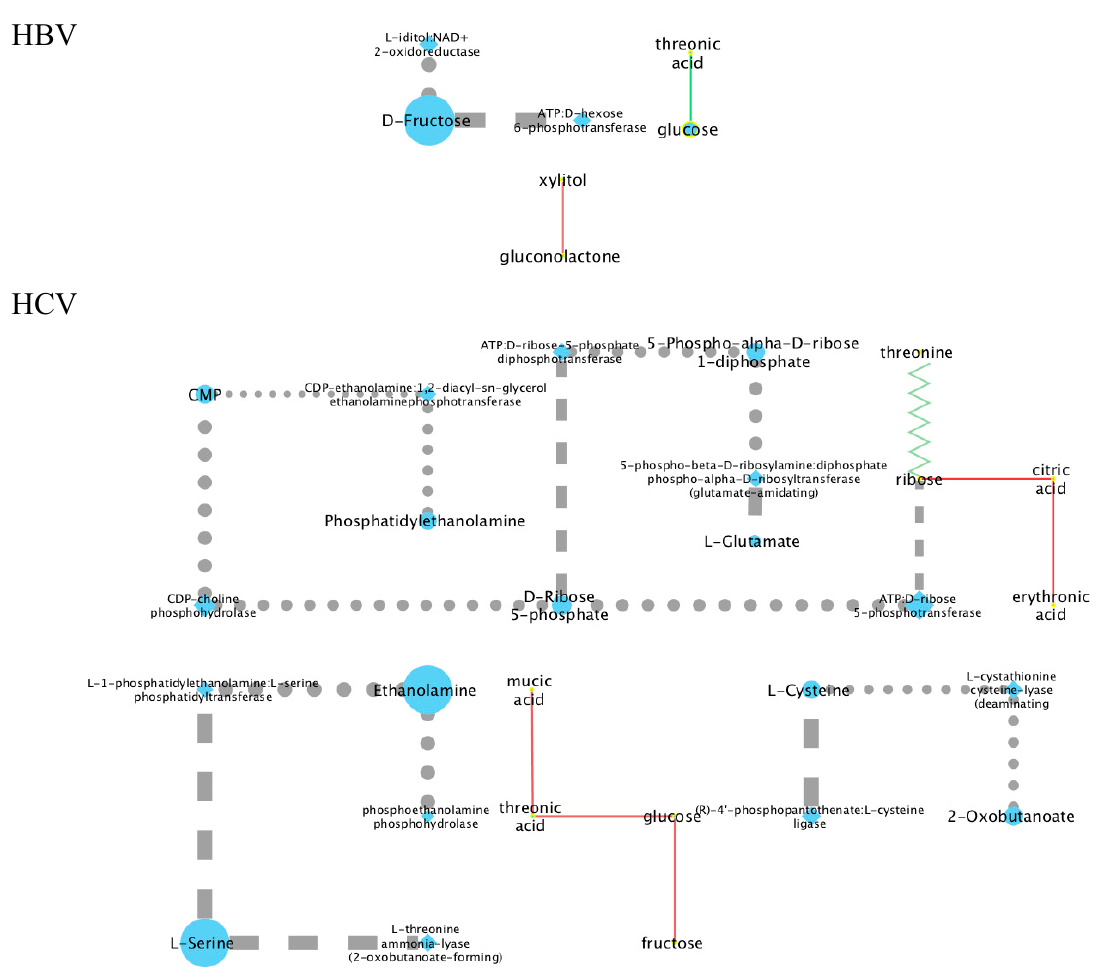
Figure A1. Integrated perturbation and metabolic network for the HBV and HCV urine samples. Circle nodes represent metabolites, and diamonds represent enzymes. Dashed lines represent enzyme-substrate relations, and dotted lines enzyme-product relations; solid lines are appearing correlations in the metabolic perturbation network (Figure 4). The size of the node and thickness of the edge represent the relative significance.